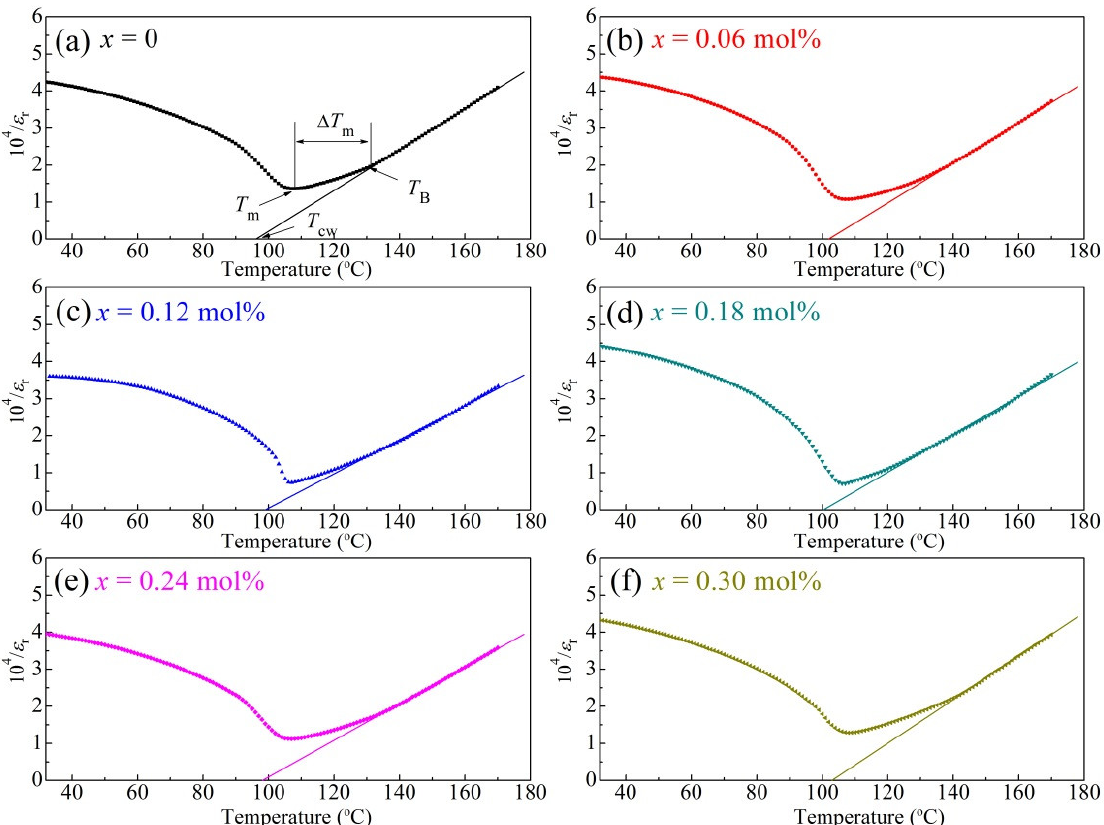
Figure 4. Temperature-dependences of the inverse permittivity (10 4 / ε r ) of the BCTZ-NY x ceramics with varying yttrium contents ( x ) of ( a ) 0, ( b ) 0.06, ( c ) 0.12, ( d ) 0.18, ( e ) 0.24, and ( f ) 0.30 mol% at a frequency of 10 kHz.